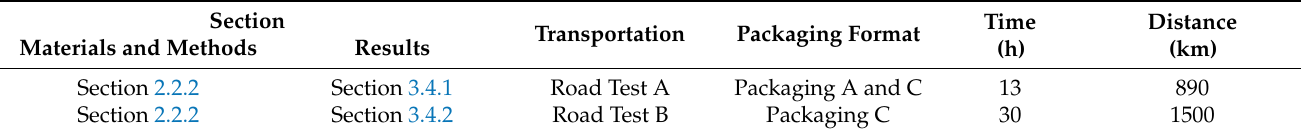
Table 2. Experimental design of road transportation.